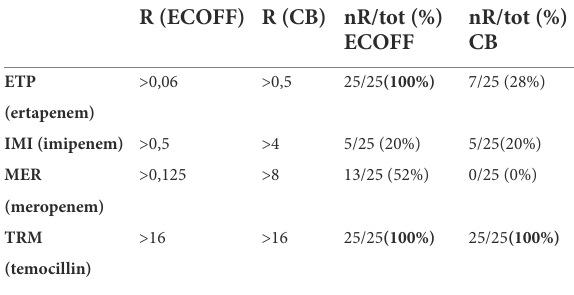
TABLE 1 Epidemiological cutoffs (ECOFFs) and clinical breakpoints for carbapenems and temocillin, with number (nR) and percentage (%) of E. coli resistant isolates from the survey at